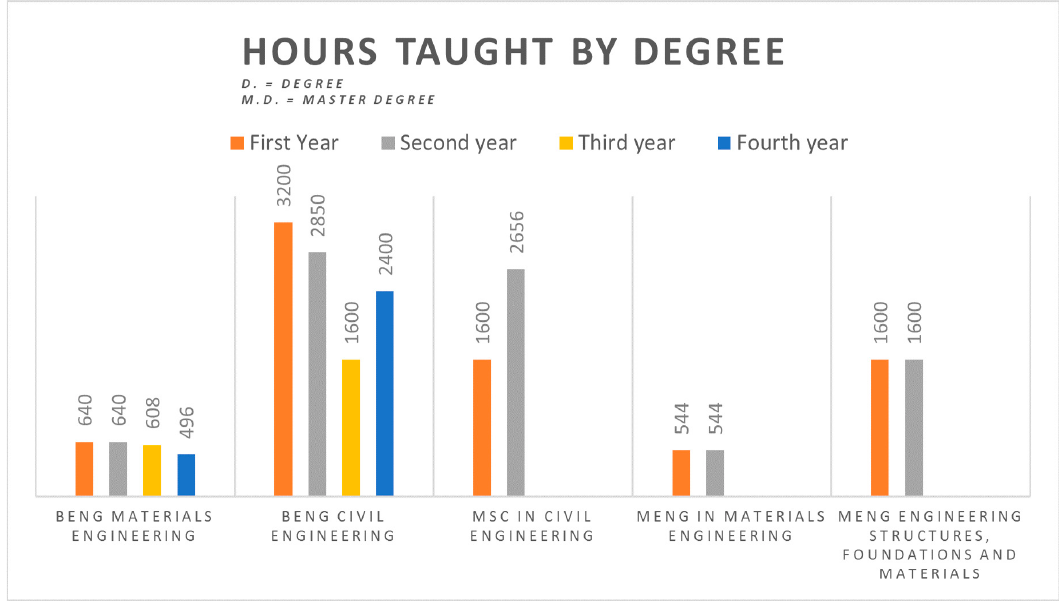
Figure 11. Hours taught by